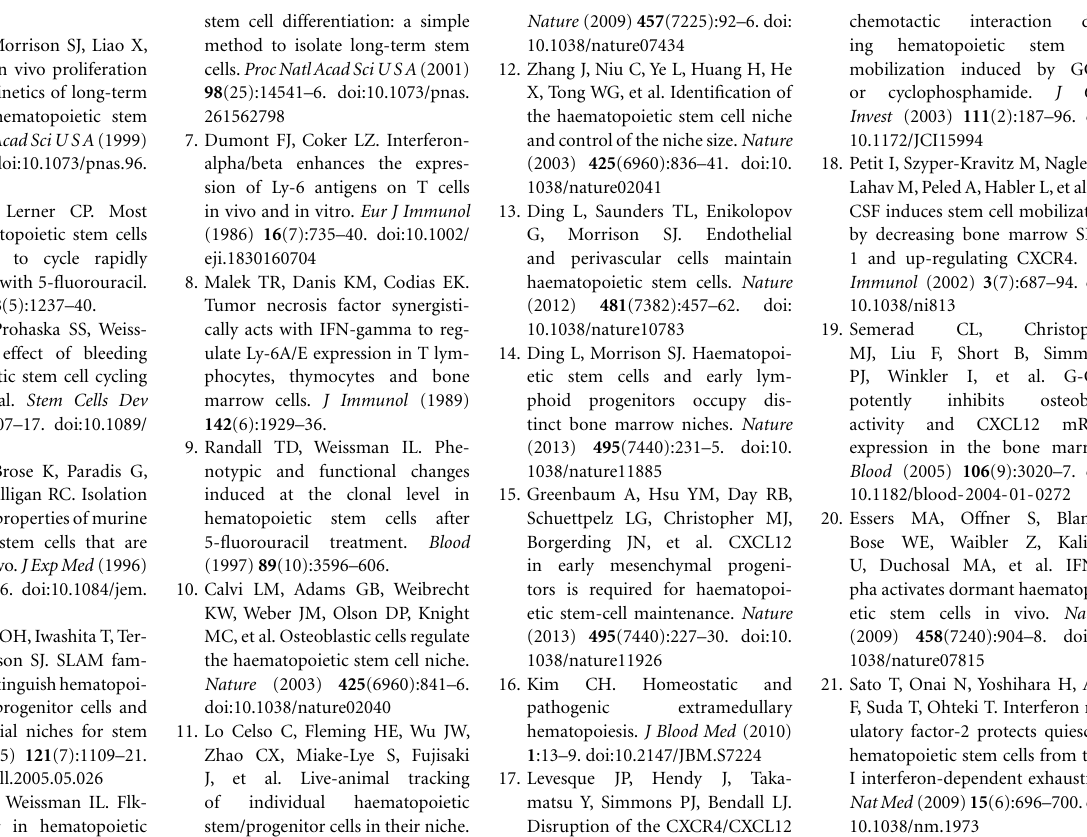
as an understanding of the signals that are dysregulated in var- avenue for targeted therapies in these diseases by interfering with (or augmenting) such